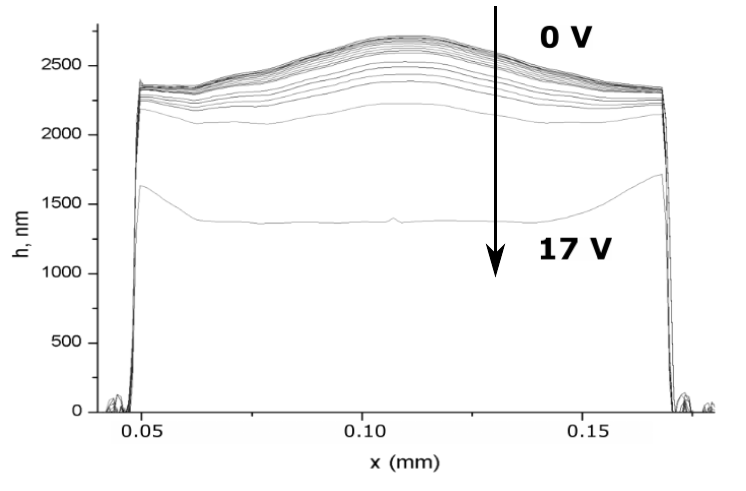
Figure 5. A set of membrane profiles when changing the control voltage from 0 to 17 V. Because the geometry of the support used by us in the form of lateral feet has a sufficiently high stiffness, when voltage is applied, the outer part bends less than the central one. It allows us using both interference methods for controlling the position of the membrane, when the detection beam is oriented in its central part, and amplitude methods, when using an inclined part of the profile. The bottom profile corresponds to a voltage, applied outside the operating range, at which the membrane falls on the bottom plane. Figure 6 shows the dependence of the membrane bias on the external stress for a membrane with a thickness of 0.4 µ m and different widths of the skid feet of 15, 30 and 100 µ m (solid feet).